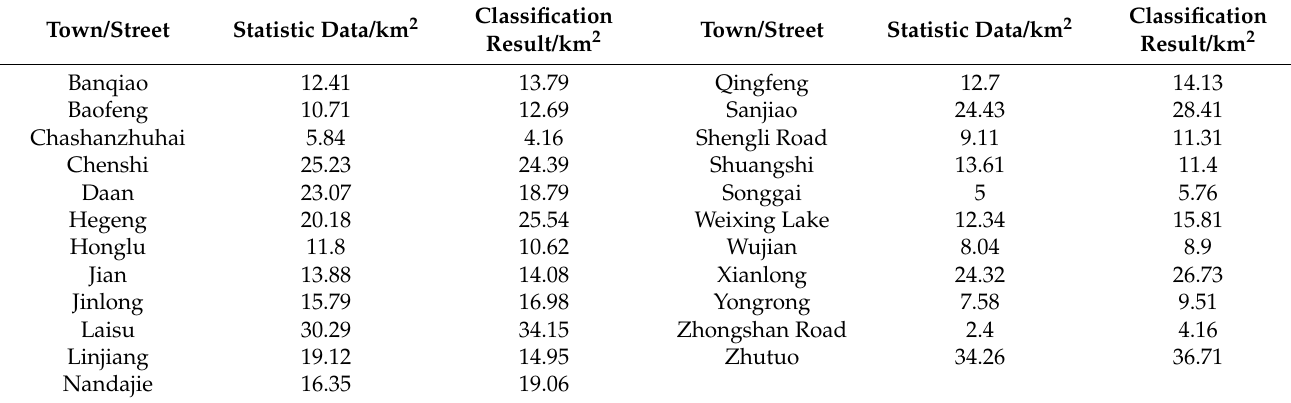
Table 6. Comparison of the paddy rice area map and official statistics at the town and street level.